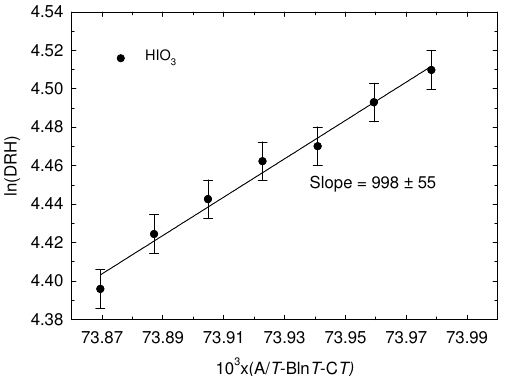
Fig. 7. A plot of measured deliquescence RH values for HIO 3 against the temperature function which includes fitted solubility data (see Sect.